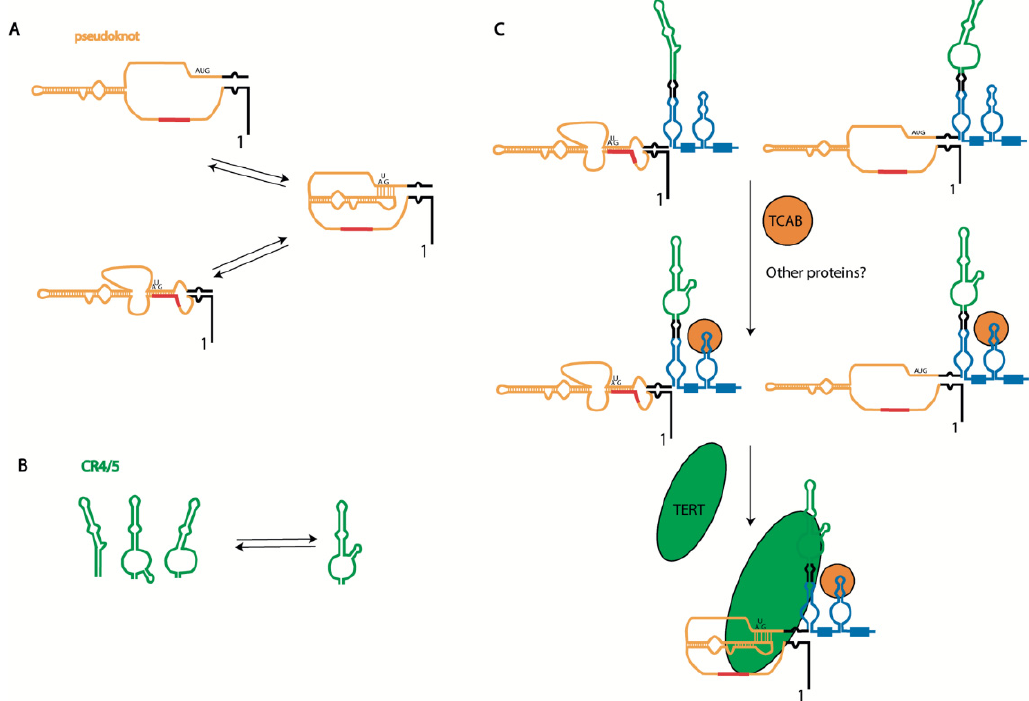
Figure 3. Biogenesis ‐ driven human telomerase RNA structure formation: ( A ) alternative structures of pseudoknot domain of hTERC ; ( B ) alternative structures of CR4/5 domain of hTERC ; and ( C ) scheme illustrating hTERC structure formation during telomerase complex assembly. The primary synthesized hTERC transcript may be folded into two alternative structures [45,49]. Binding of TCAB1 facilitates folding of the P6.1 stem and CR4/CR5 domain and Cajal body localization [39], where TERT binding promotes pseudoknot formation associated with proper template region positioning with respect to the enzyme active center